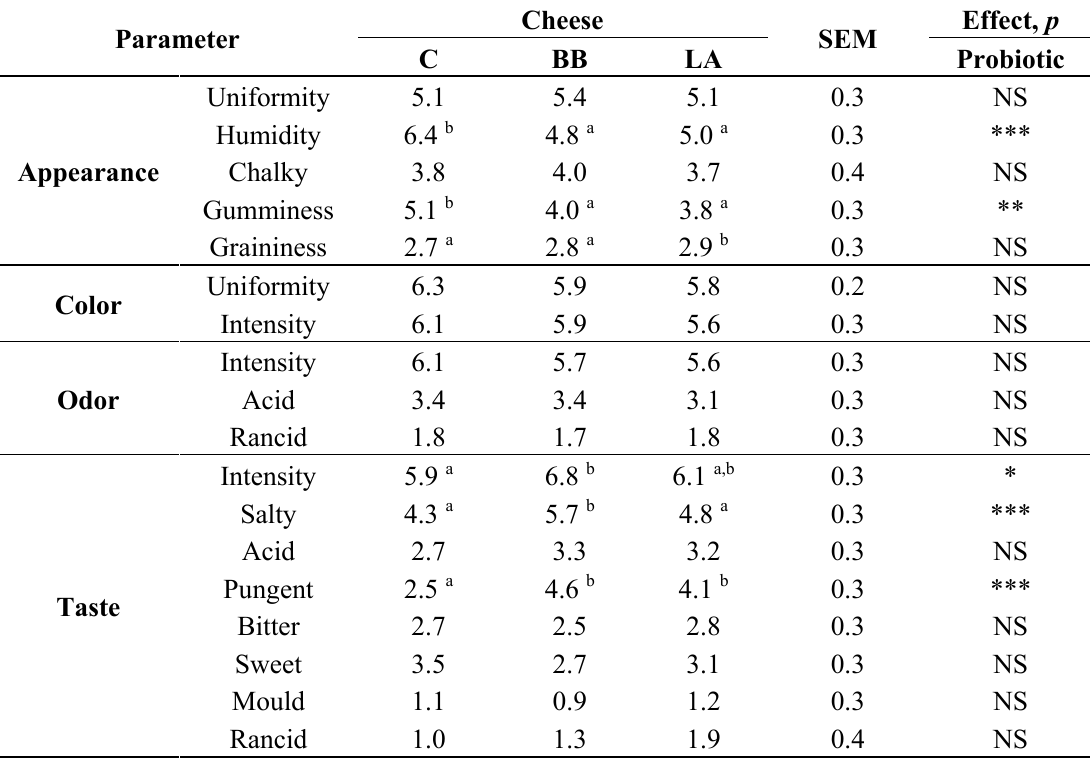
Table 3. Sensorial attributes of probiotic ovine cheese at 45 day of